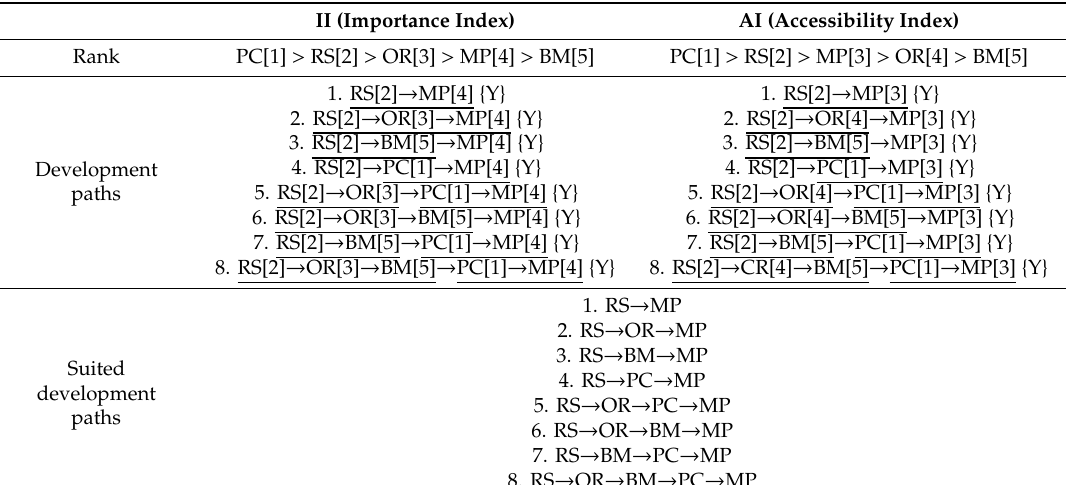
Table 16. The suited development paths for